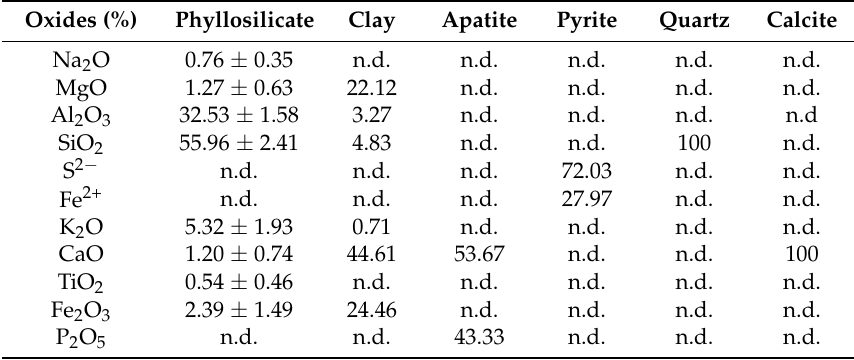
Figure 5. SEM analysis in the coal refuse sample: ( A ) compact aggregates; ( B ) detail with clay aggregates containing different ions; ( C ) aggregates of phyllosilicates with folded edges; ( D ) aggregates containing organic matter and pyrite crystals; ( E ) calcite and MK rhombohedrum in the coal-refuse sample thermally activated at 600 ◦ C; ( F ) detail of activated phyllosilicates and MK. Table 4. Chemical analysis by EDX of the aggregates from the coal-refuse